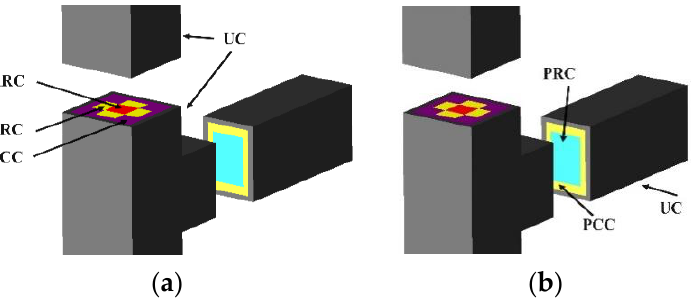
Figure 1. Confined concrete in different regions: ( a ) concrete in the column; ( b ) concrete in the beam.